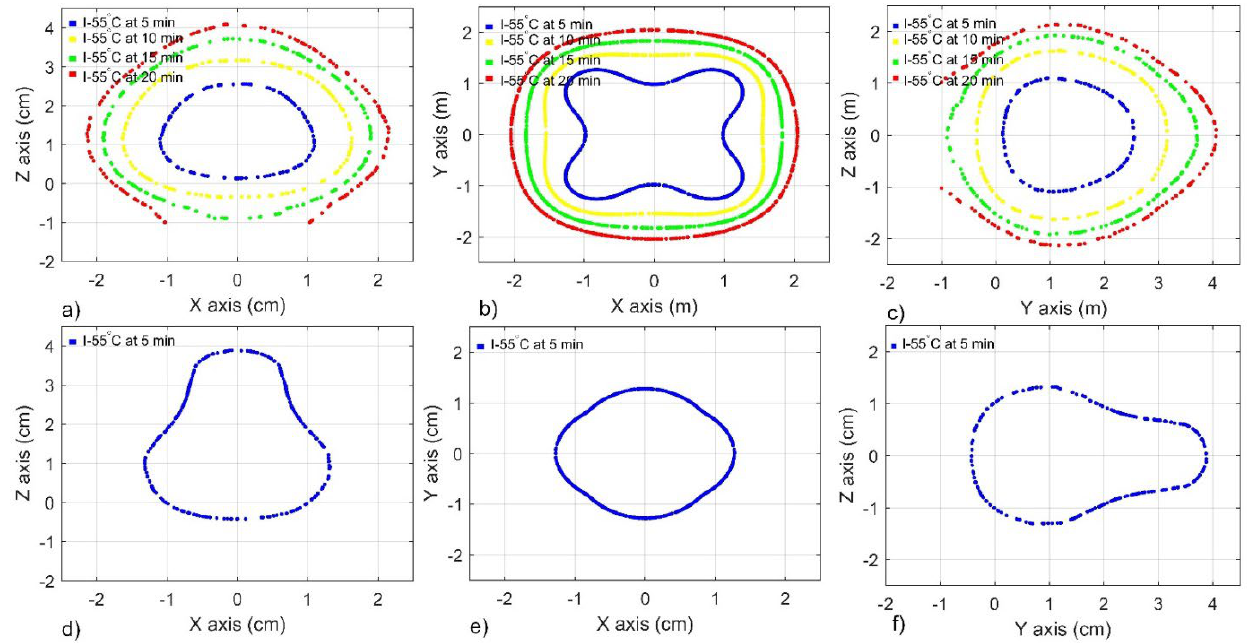
Figure 11. Isotherm contour at 55 °C that was generated by a square antenna array over different planes after 5 min, 10 min, 15 min, and 20 min of treatment time. ( a )–( c ) XZ, XY, and YZ planes for a DS antenna array with ad = 15 mm and bt = 40 mm, respectively ; ( d )–( f ) XZ, XY, and YZ planes for a MTM antenna array with ad = 10 mm and bt = 25 mm, respectively.